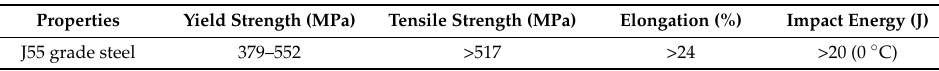
Table 2. Mechanical properties of J55 steel in API Specification 5CT/ISO 11960 [18].